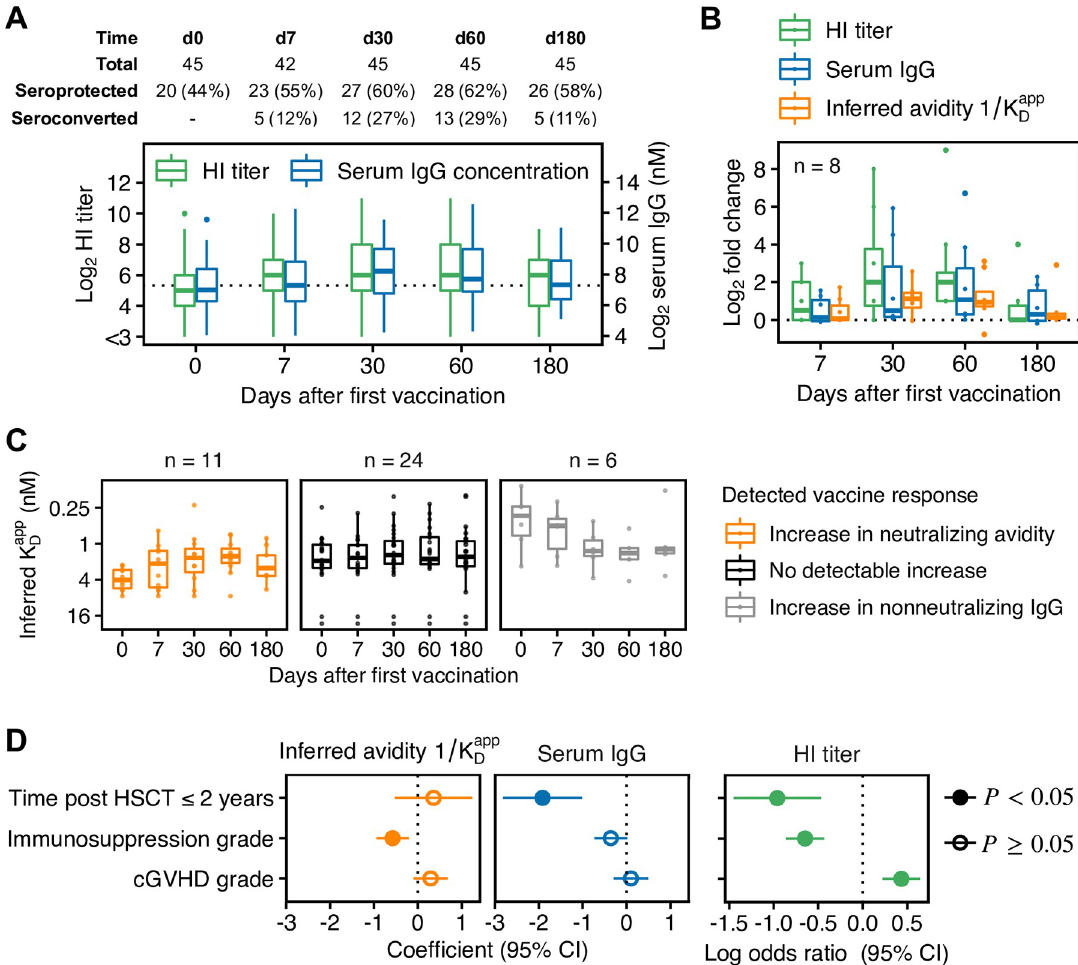
Fig 4. Response to influenza vaccination against H1N1pmd09 in HSCT patients. ( A ) HI titers and ELISA-detected serum IgG concentrations in the investigated patient population. Patients were vaccinated on d0 and d30 with a non-adjuvanted trivalent influenza vaccine. Seroprotection corresponds to HI titer � 40 and seroconversion to a four-fold HI titer increase compared to d0. ( B ) Fold changes in HI titer, serum IgG and inferred avidity ( 1 = K app ) in all patients with a detectable increase in inferred avidity on d30 and/or D d60. ( C ) Comparison of inferred avidities between patients with a detectable increase in avidity at any time point after vaccination (left), patients with no detectable increase (middle), and patients with a detectable increase in non-neutralizing IgG (right). We excluded 4/45 patients as they showed too large measurement uncertainty in IgG concentration on several time points. ( D ) Estimated effects on baseline levels of criteria for compromised immune response. Effects were estimated in a multivariable regression analysis on log2-transformed values controlling for sex and age. Time after HSCT was encoded as a binary variable (1 for HSCT � 2 years and 0 for HSCT > 2 years). Immunosuppression grade and cGVHD grade ranging from 0 (no immunosuppression/cGVHD) to 3 (severe immunosuppression/cGVHD) were encoded as ordered categorical variables with grade 0 as reference (see Methods for details).